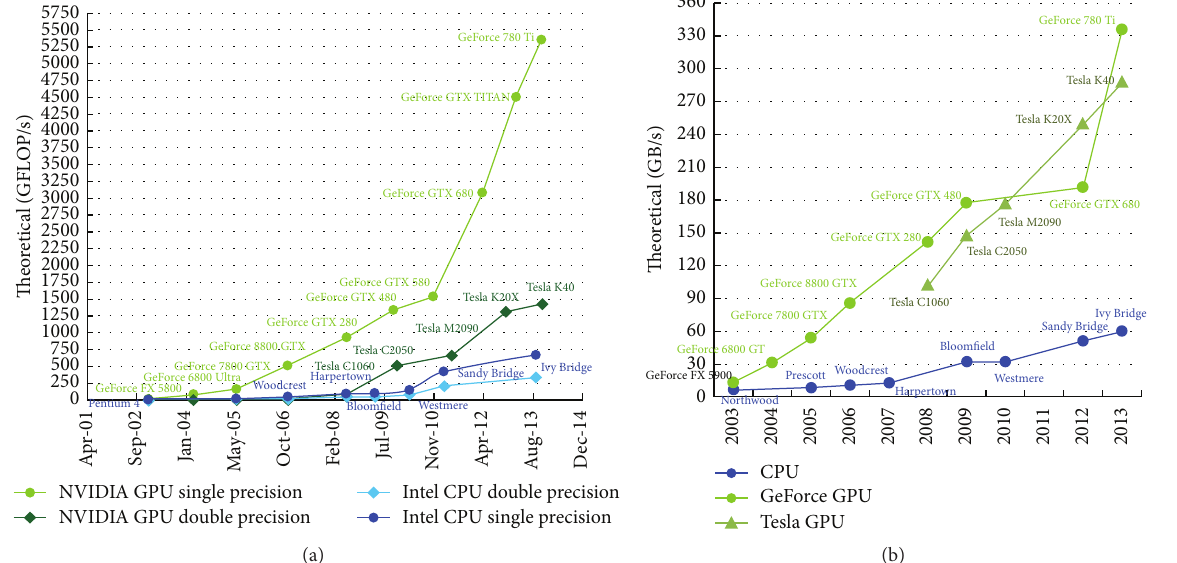
Figure 1: Comparison of computation capability of CPU and GPU: (a) floating-point operations per second (FLOP/s) for the CPU and GPU; (b) memory bandwidth for the CPU and GPU